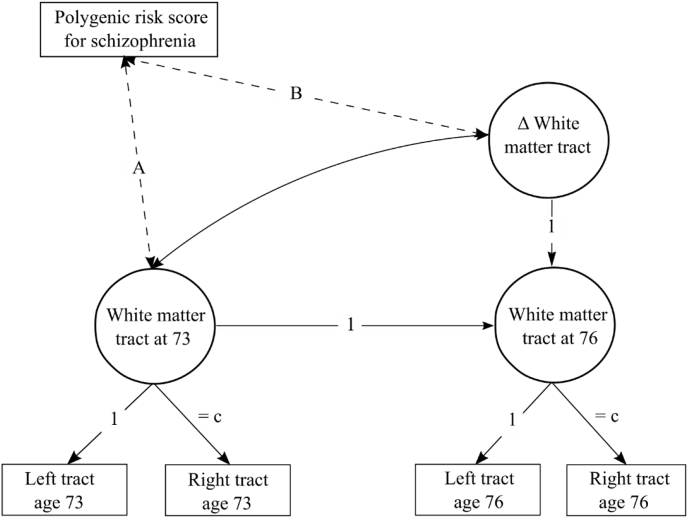
Diagram of the structural equation model (SEM) for white matter connectivity. A separate model was applied to each white matter tract (FA and MD) and each graph theory measure. Water diffusion and graph theory metrics were measured at baseline (age 73) and follow-up (age 76). From each individual bilateral white matter tract, a latent score was calculated for FA and MD. For callosal tracts and graph theory metrics a latent score was derived after the manifest variable was corrected for scaled age at scanning and sex. From these models, a latent change score variable was calculated for each model (Δ Connectivity). Relation between baseline FA/MD/graph theory measures and polygenic risk score for schizophrenia (szPGRS) is indicated by path A; path B represents the association between change in white matter FA/MD/graph theory measures and szPGRS. For all bilateral tracts, we further constrained equality of the factor loading of the left hemisphere (c). szPGRS was corrected for sex and population stratification while water diffusion MRI and graph theory measures at the manifest level were corrected for scaled age at scanning and sex at each time point within the model (paths not shown). Note that graph theory metrics were corrected for density outside the SEM model.